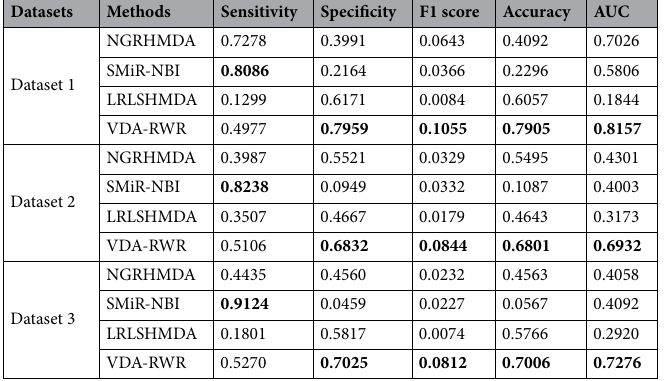
Table 2. The performance comparison of four methods on three datasets under CV1. Bold values indicates the best values for the different methods under the same evaluation.